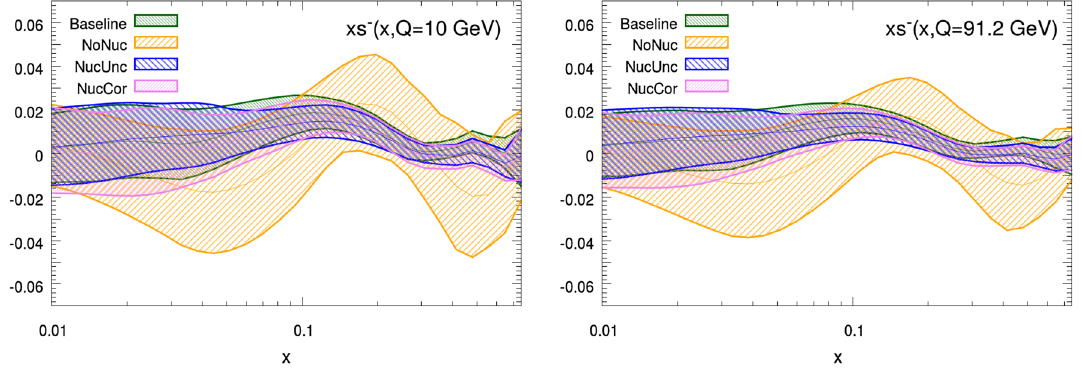
Fig. 15 The strange valence distribution xs − ( x , Q ) = x [ s ( x , Q ) − ¯ s ( x , Q ) ] as a function of x at two values of Q : a typical scale for the nuclear data ( Q = 10 GeV), and for the collider data ( Q = 91 . 2